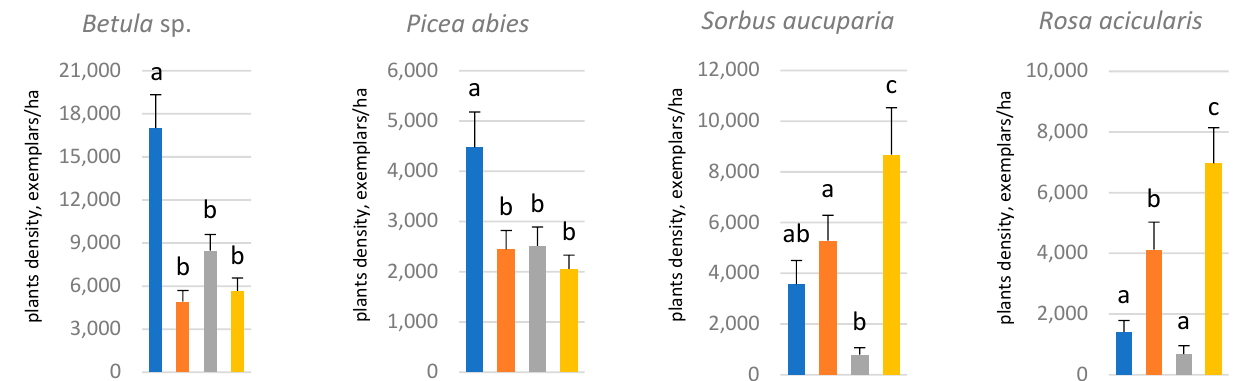
Figure 3. Amount of woody regeneration and understory in the clear-cut adjoining the forest edge in different cardinal directions: northern, eastern, southern, western. Letters indicate differences between means (based on the analysis of variance).